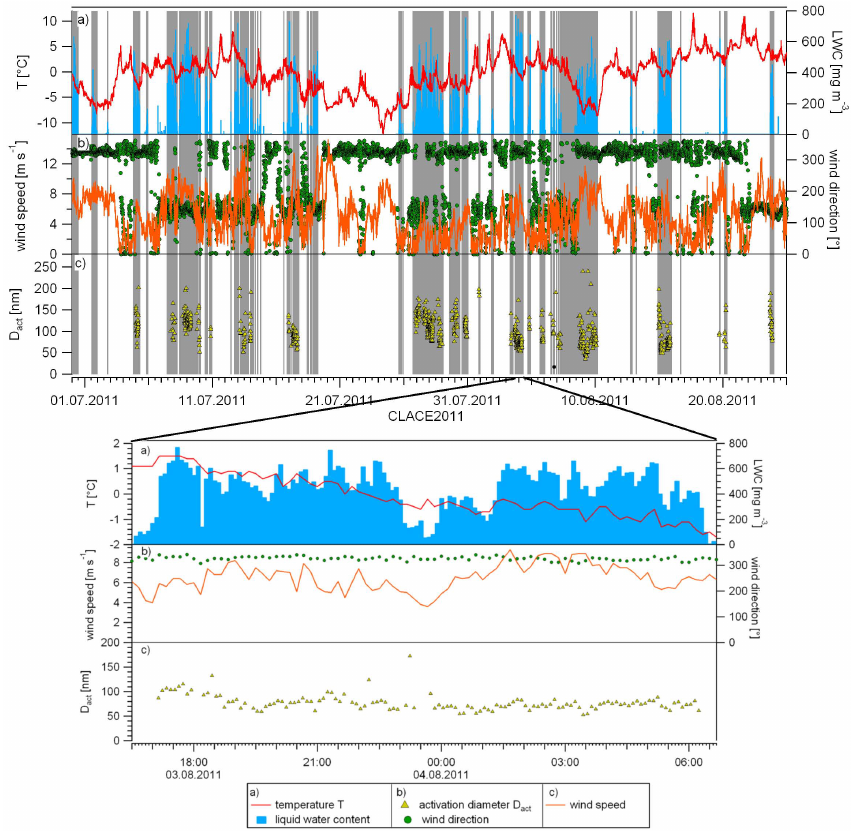
Fig. 6. Measured meteorological parameters during CLACE2011: (a) temperature ( T ) and relative humidity (RH) (b) measured wind direc- tion and horizontal wind speed (c) ambient activation diameter D act . In grey the classified cloud periods during CLACE2011 are depicted by applying the cloud period criterion explained in Sect. 3.1. Below is a zoomed-in case example for the cloud period from 3 August 2011 16:30 to 4 August 2011